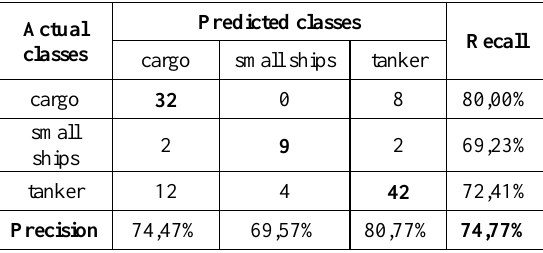
Table 2. Confusion matrix for a classification scheme using all extracted features.